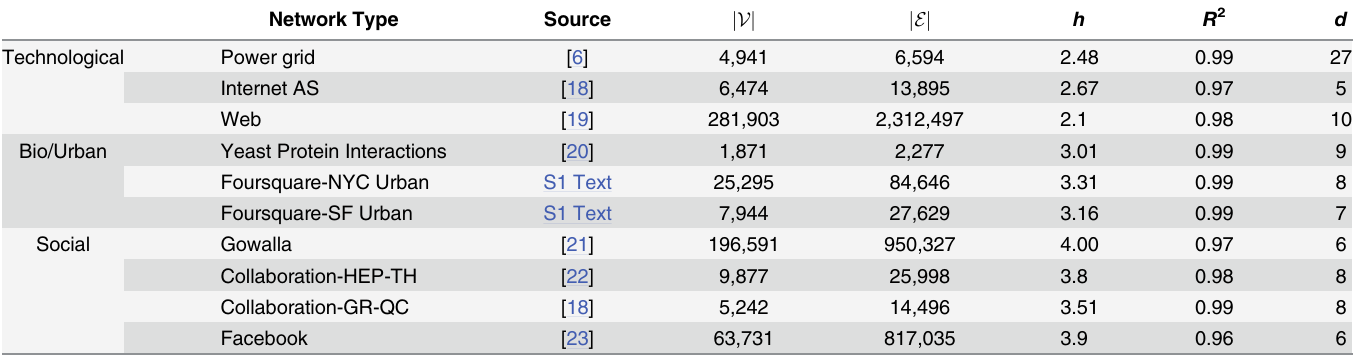
Table 2. Pervasiveness of the power-hop scaling. Basic information about the different real network datasets used for our power-hop analysis. For every network we also provide the calculated h and the corresponding R 2 of the fit, as well as the effective diameter d